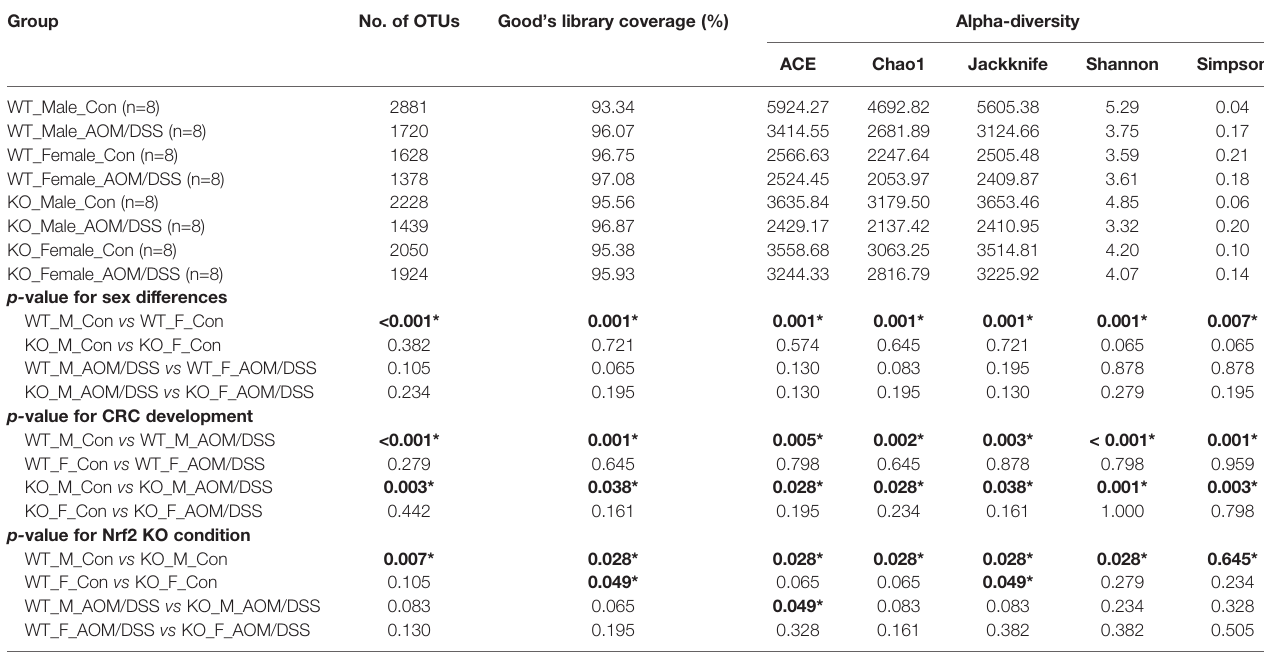
TABLE 1 | Alpha diversity of microbiota from fecal contents. Group No. of OTUs Good ’ s library coverage